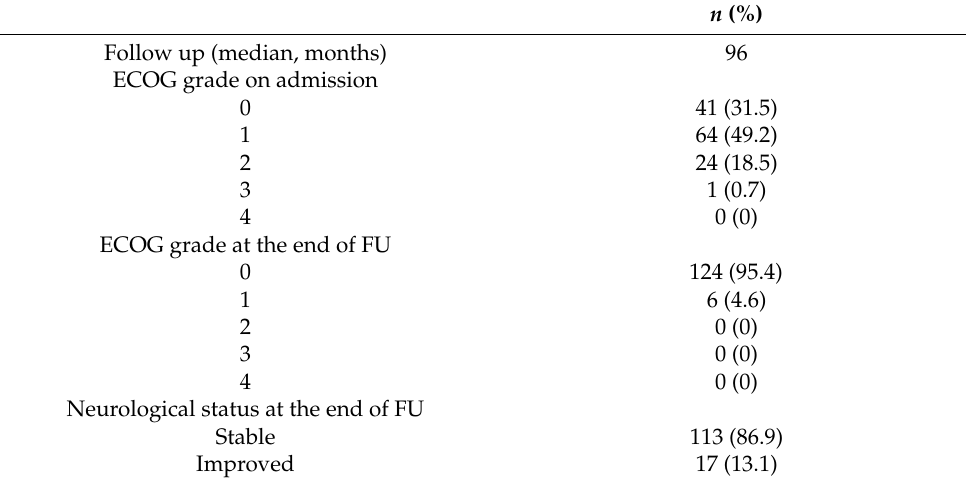
Table 3. Outcome